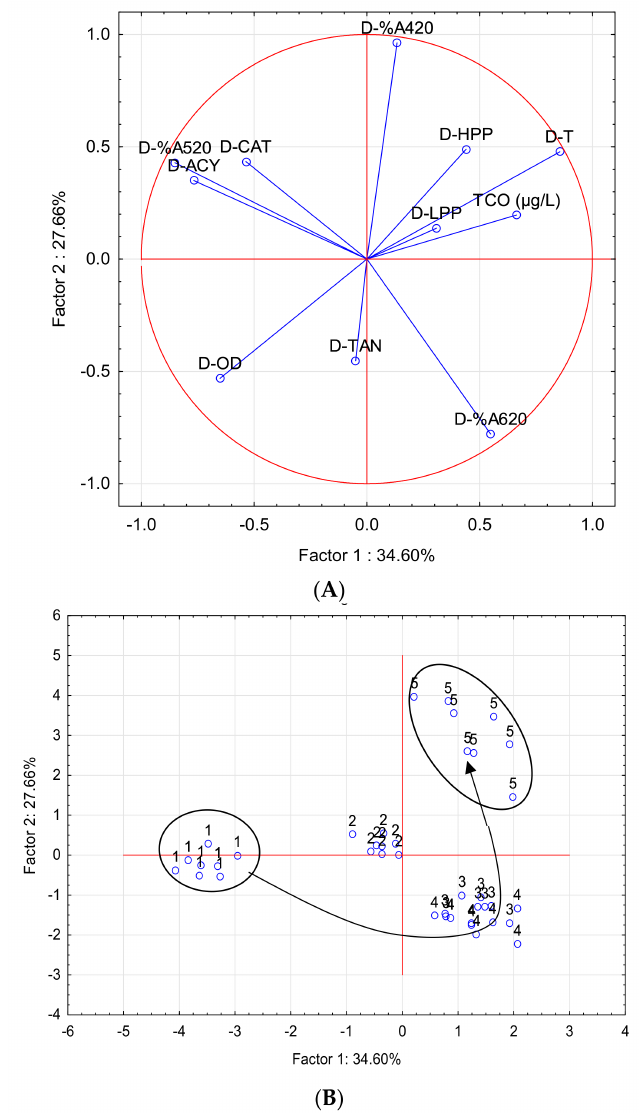
Figure 4. Principal component analysis (PCA) performed with global phenol parameters in wines from different micro-oxygenation and wood strategies. 1, 2, 3, 4, and 5: samplings carried out in each tank after 20, 48, 76, 97, and 111 days’ aging,